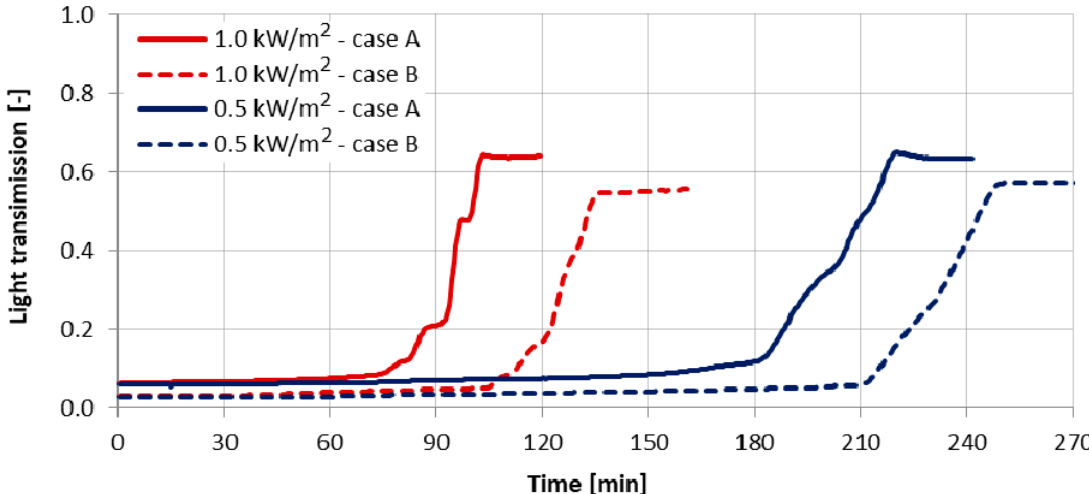
Figure 6. Direct light transmission versus time for triple glazed window with PCM layer—melting process caused by irradiation from an artificial sun.